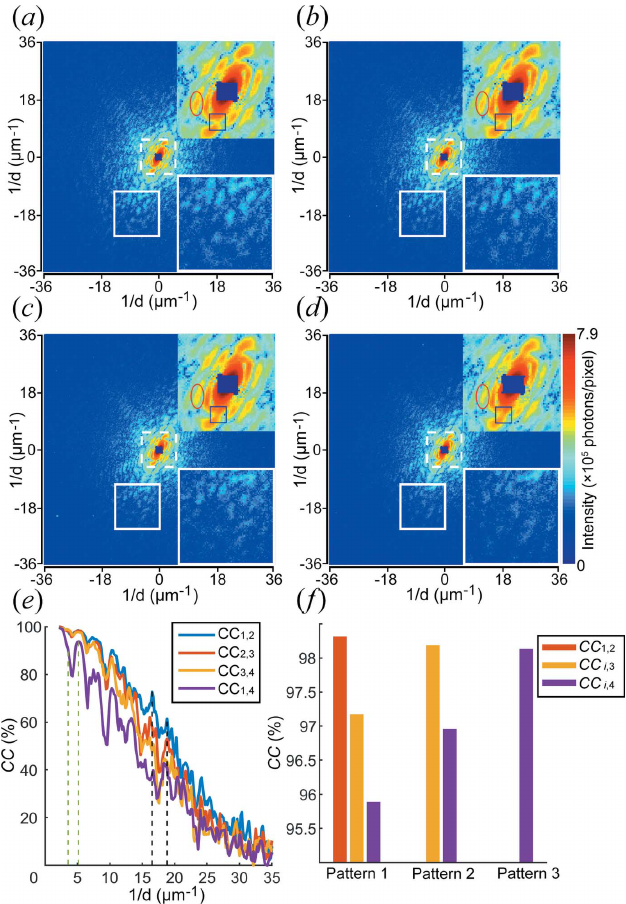
Figure 5 ( a )–( d ) X-ray diffraction patterns of the mitochondrion at different cumulative radiation doses after 3 (cid:2) 3 binning and deconvolution. The images in the upper right corner are magnifications of the dashed squares in the centres of the patterns and the images in the lower right corner are magnifications of the solid squares in the patterns. The red ellipses and blue squares correspond to the region bounded by the two green dashed lines in panel ( e ) with a frequency range from 3.5 to 5.2 m m (cid:5) 1 . The white squares correspond to the area between the two black dashed lines in panel ( e ) and the frequency in this range is from 16.5 to 18.9 m m (cid:5) 1 . ( e ) The cross correlation (CC) plotted as a function of the resolution shell between two given patterns. ( f ) The CC between the three patterns. The abscissa represents the CC between the corresponding pattern and others. For example, the yellow bar in the group labelled ‘Pattern 2’ represents the CC between the second and third diffraction patterns.